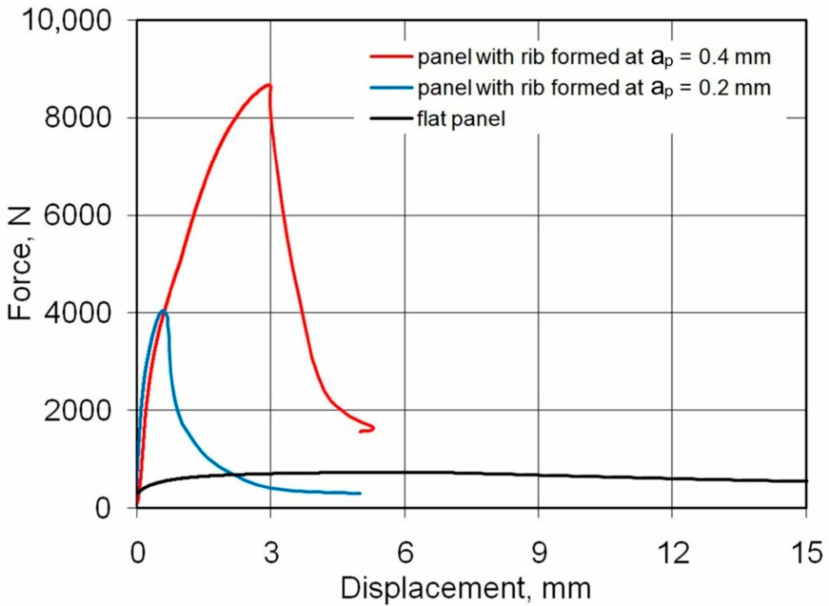
Figure 11. Load-displacement curves of the panels fabricated from 0.8-mm-thick EN AW-7075-T6 Alclad panels subjected to compression